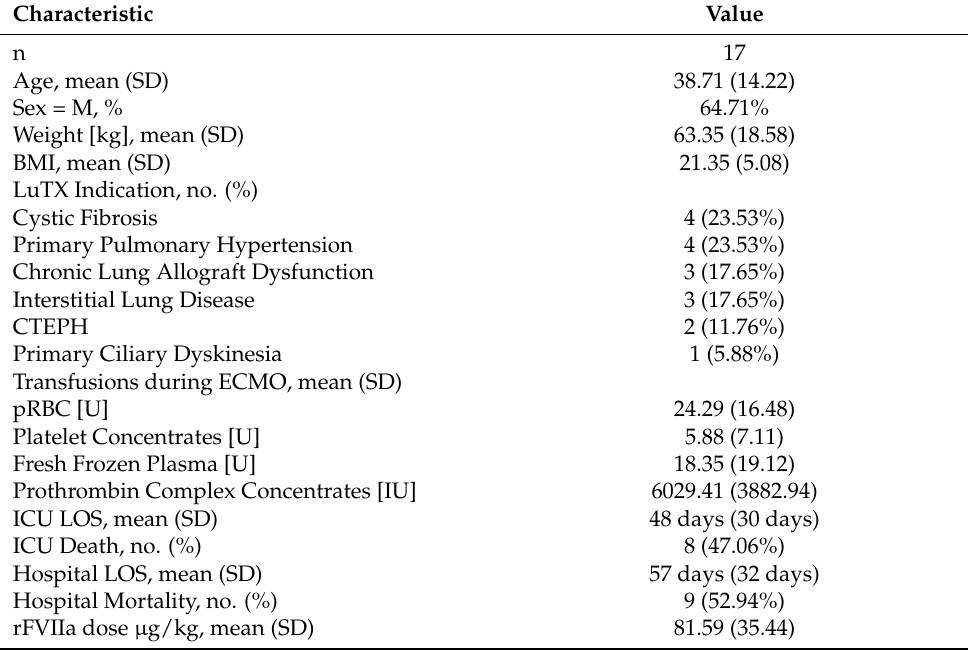
Table 1. Characteristics of the included patients. no. = number of patients; SD = standard deviation; µ g = micrograms; kg = kilograms; cm = centimeters; BMI = body mass index; CTEPH = chronic thromboembolic pulmonary hypertension; pRBC = packed red blood cells; LOS = length of stay; LuTX = lung transplantation; ECMO = extracorporeal membrane oxygenation; U = unit; IU = international units; rFVIIa = recombinant, activated Factor